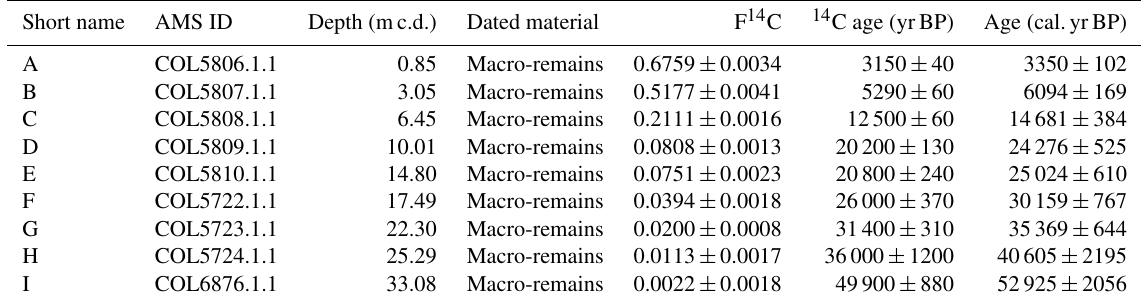
Table 2. Radiocarbon isotope data and ages. Short names are used in the figures and discussion in this study. The macro-remains were too small for an unambiguous identification and may be of mixed aquatic and terrestrial origin. Calibrated ages are given with 2 σ uncertainty ranges.